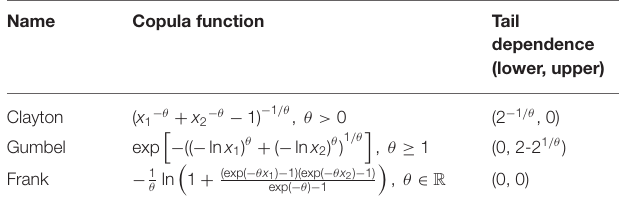
TABLE 1 | Examples of Archimedean copulas and their tail dependence characteristics. Name Copula